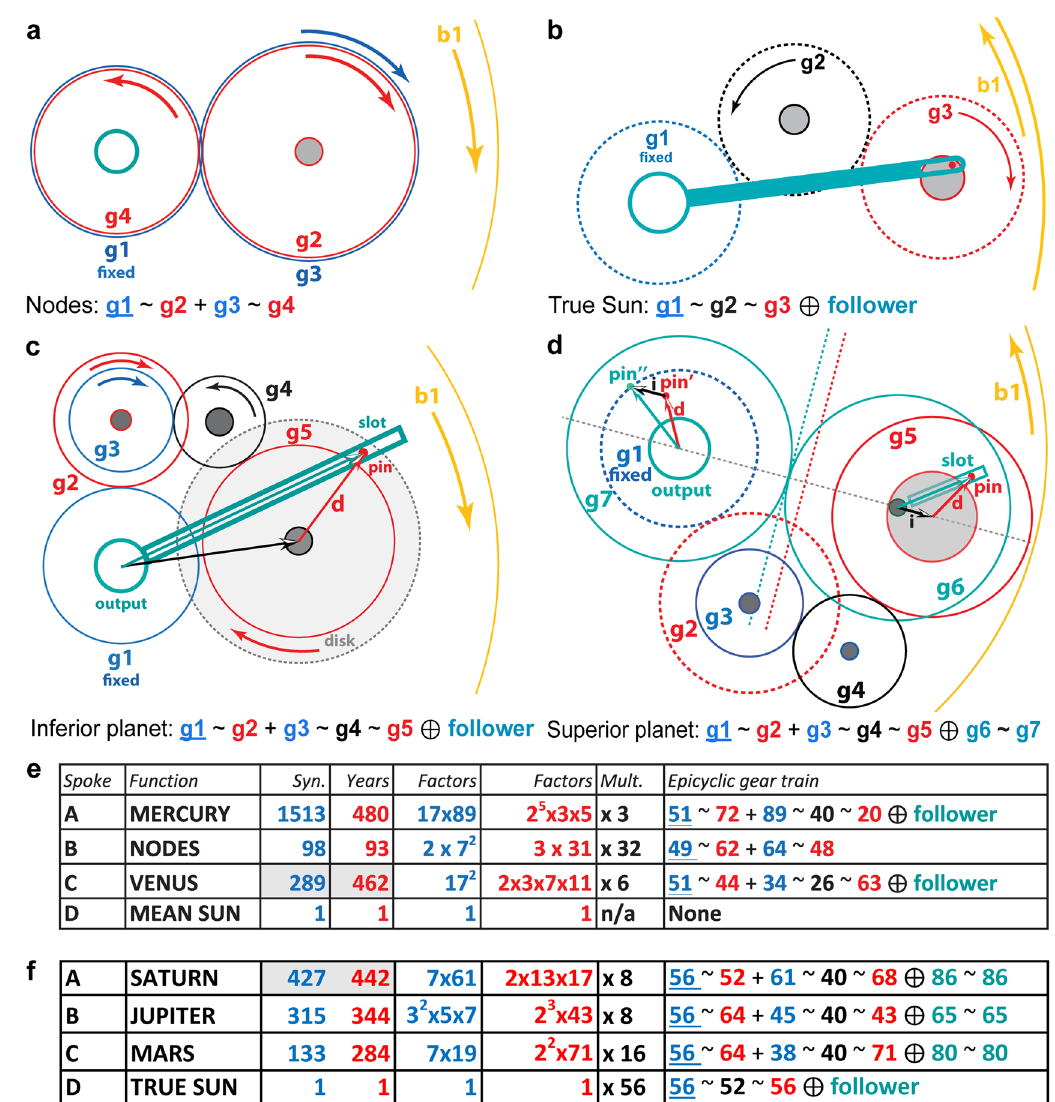
Figure 3. Epicyclic Mechanisms for the Cosmos. Fixed gears are underlined; blue gears calculate synodic cycles; red gears calculate years; black gears are idler gears: all designated by their tooth counts. “ ~ ” means “ meshes with ”; “ + ” means “ fixed to the same arbor ”; “ ⊕ ” means “ with a pin-and-follower, turning on the central axis” or “with a pin-and-slot on eccentric axes ”—creating variable motion (turquoise). Followers are slotted rods that follow a pin on the epicyclic gear and turn on the central axis. For each mechanism, there is a fixed gear at the centre, meshing with the first epicyclic gear, which is forced to rotate by the rotation of b1 or the CP . ( a ) 4-gear epicyclic system for the Line of Nodes . ( b ) 3-gear direct model for the true Sun. ( c ) 5-gear direct model for an inferior planet for complex period relations, with variable motion calculated by a pin and slotted follower. ( d ) 7-gear indirect model for a superior planet for complex period relations, with variable motion calculated by a pin-and-slot on eccentric axes. ( e ) Period relations and gear trains on the Main Drive Wheel , b1 ; Mercury & Venus share fixed 51 . ( f ) Period relations and gear trains on the Circular Plate , CP , sharing fixed 56 ; gears also shared between Saturn/true Sun and Mars/Jupiter (Supplementary Discussion